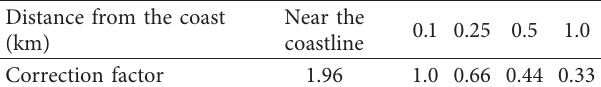
Table 5: Chlorine ion concentration M